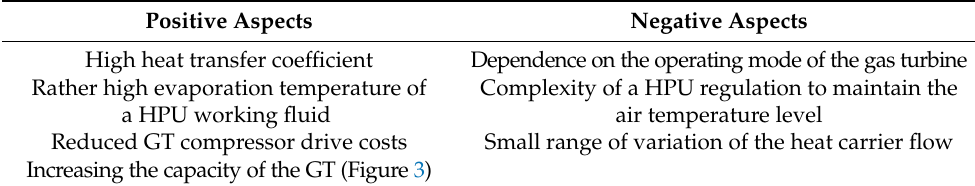
Table 5. Positive and negative aspects of using air at the intake of a gas turbine unit as a